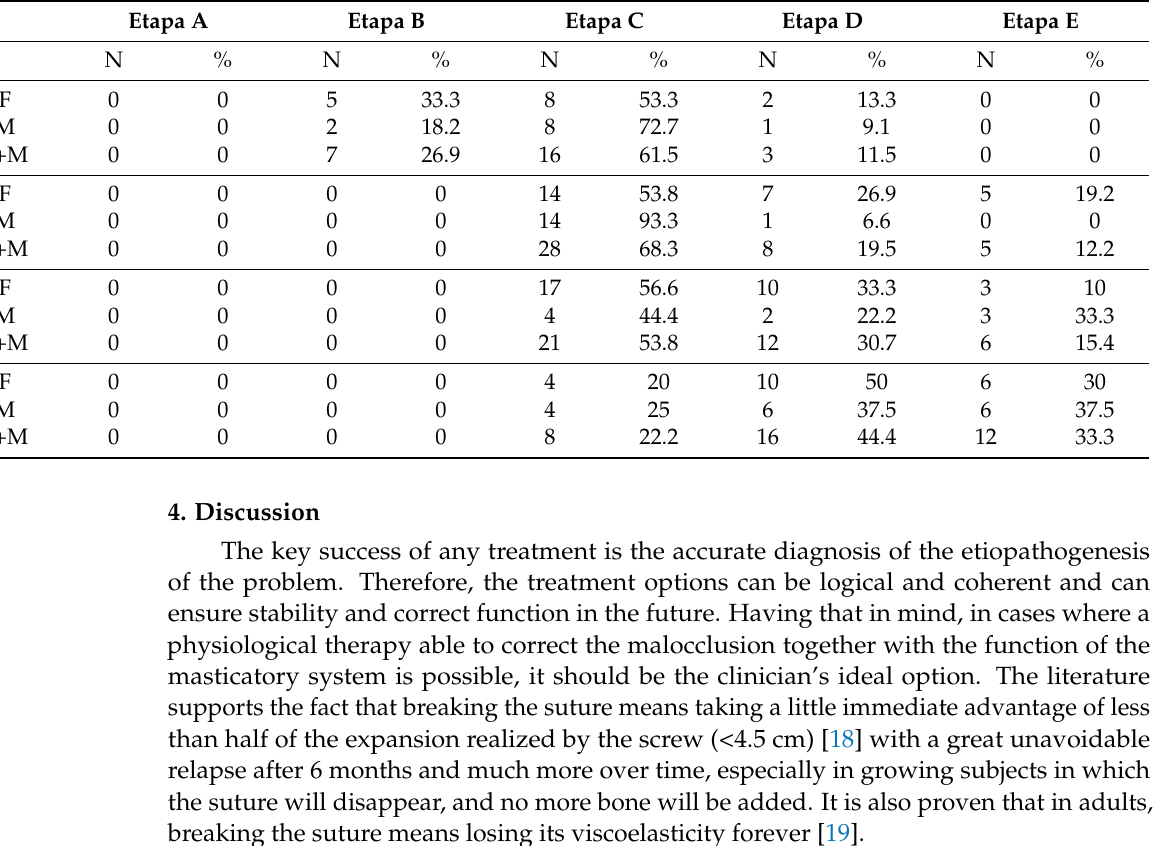
Table 3. Results of the